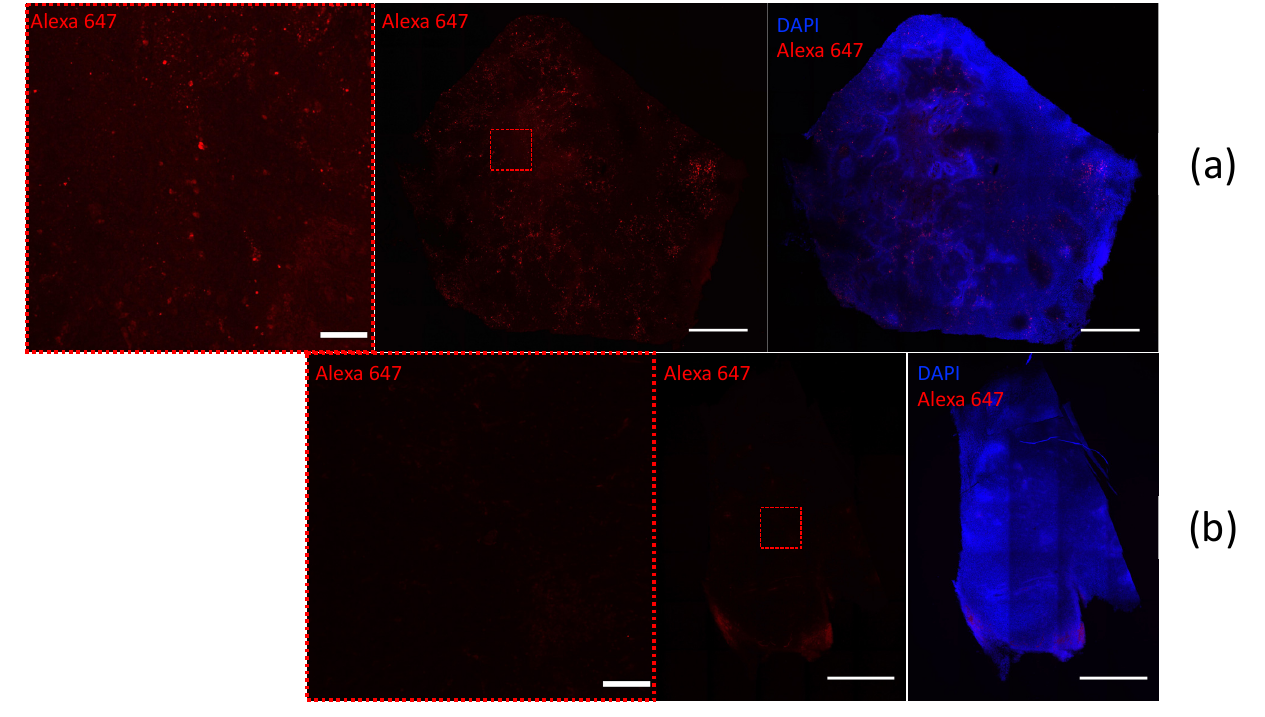
Figure 9. 4T1-Qt- ( a ) and 4T1- ( b ) cell-induced tumors sections stained with Alexa Fluor 647 anti- DYKDDDDK Tag antibody (red fluorescence). Nuclei were counterstained with DAPI (blue fluorescence). Laser scanning confocal microscopy, scale bar 100 and 1000 µm.